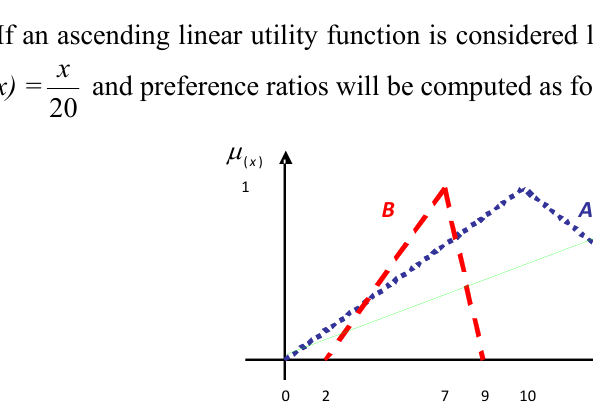
Fig. 2. Comparison of fuzzy numbers A=(0,10,20) and B=(2,7,9) considering an ascending linear utility function